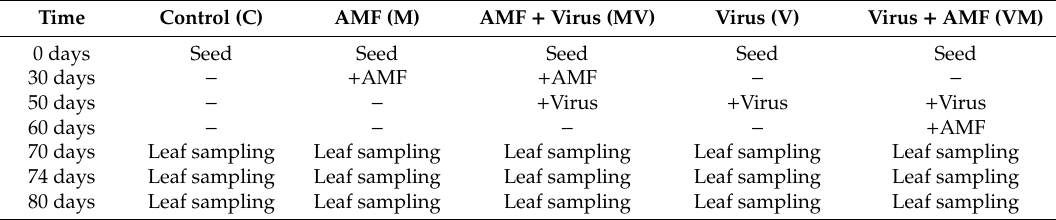
Table 1. Experimental design based on the time for each virus type.